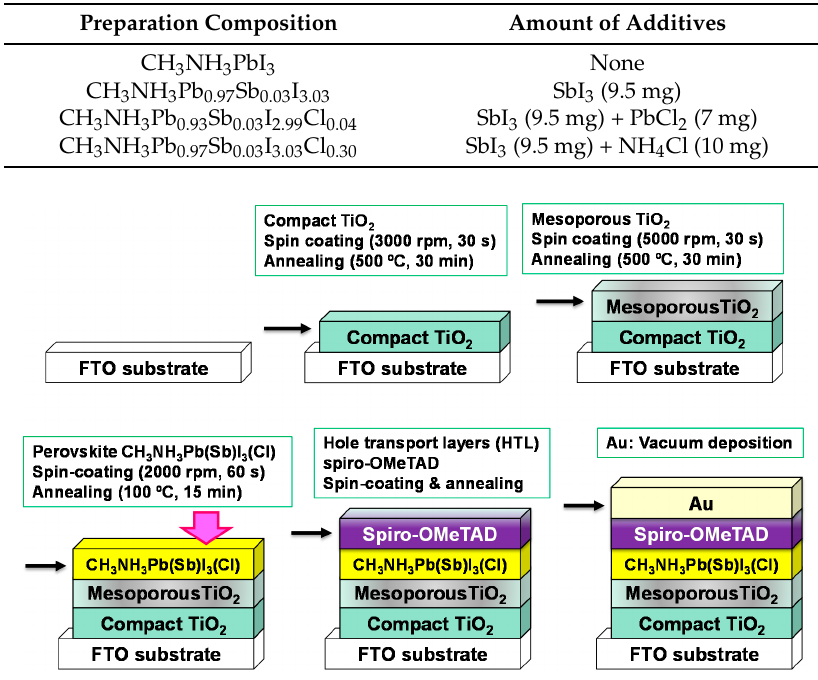
Figure 1. Schematic illustration for the fabrication of CH 3 NH 3 Pb 1 ‐ x Sb x I 3 ‐ y Cl y photovoltaic